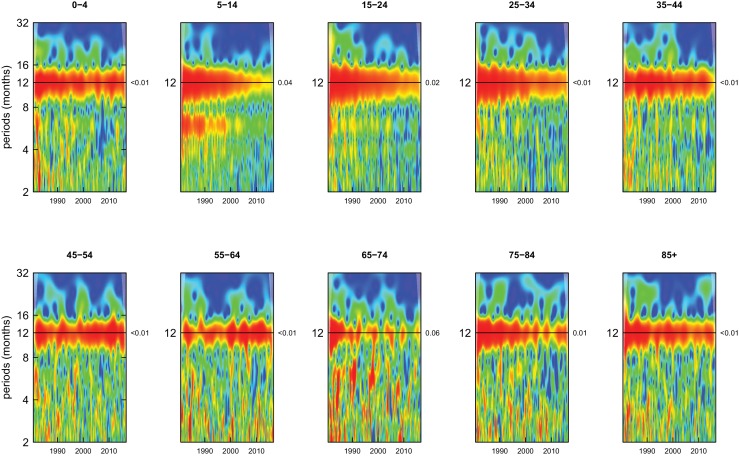
Wavelet power spectra for national time series of unintentional injury death rates for 1980–2016, by age group for males.Wavelet power values increase from blue to red. The shaded regions at the left and right edge of each box indicate the cone of influence, where spectral analysis is less robust. P-values for the presence of 12 month seasonality are to the right of each figure at the 12 month line.